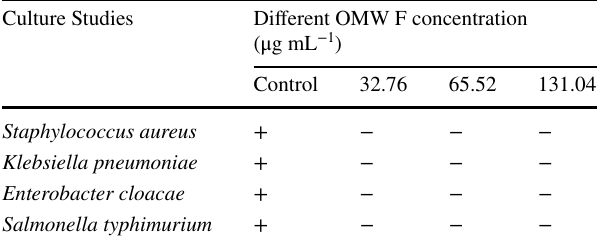
Table 6 Antibacterial activity of different OMW F concentra- tion (μg mL −1 ) against the flowing bacteria: Gram-positive bacteria ( Staphylococcus aureus ) and Gram-negative bacteria ( Klebsiella pneumonias, Salmonella typhimurium and Enterobacter cloacae )